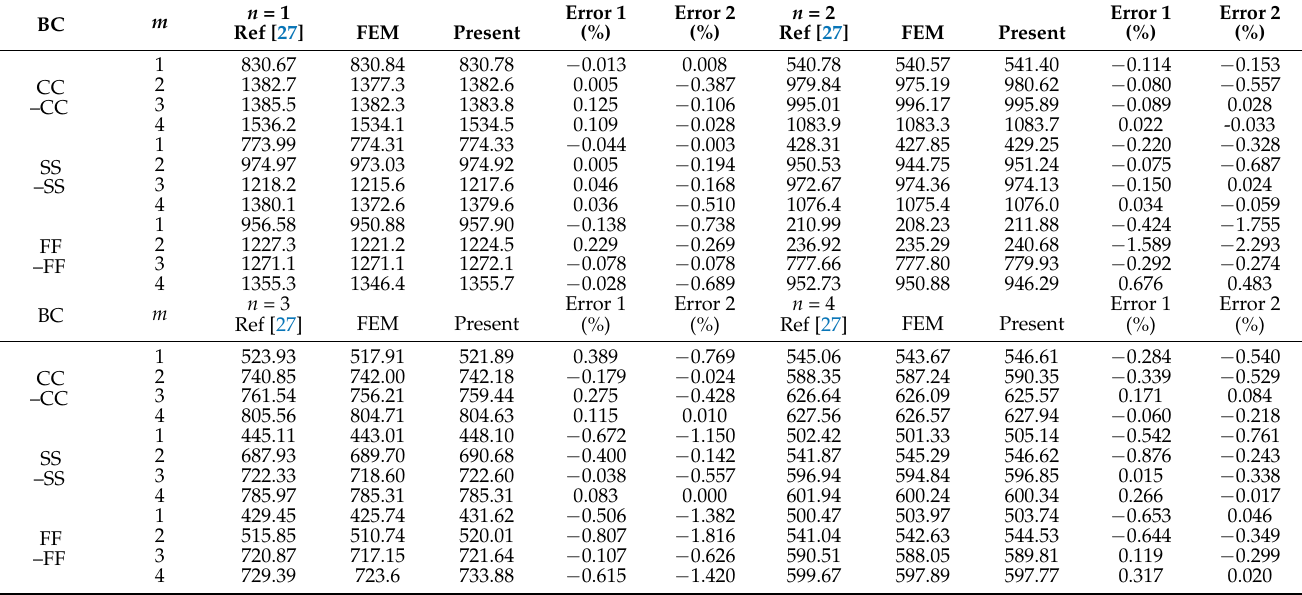
Table 2. The first four natural frequencies of DCSS coupled with three annular